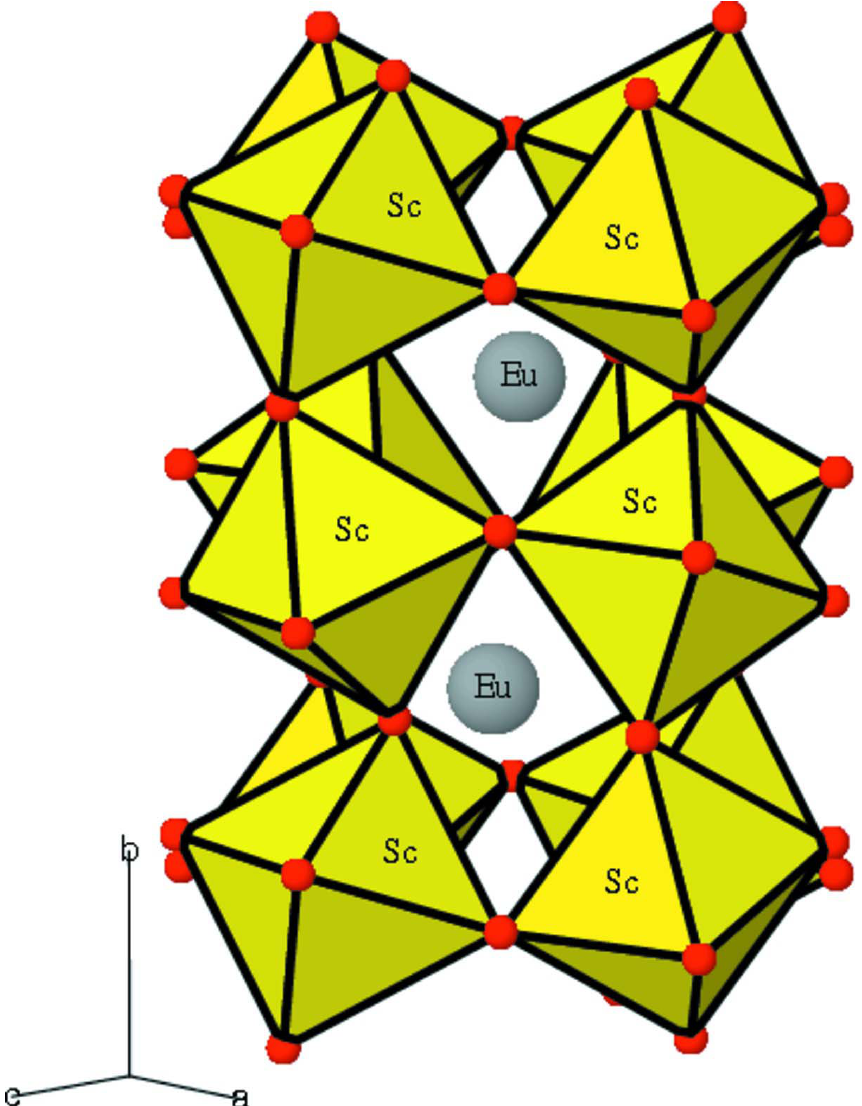
is characterized by a tilted corner sharing ScO 3 octahedra are yellow, the Eu atoms are given in grey and the O 6